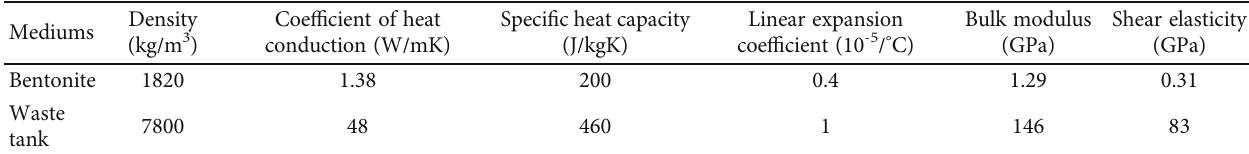
Table 2: Calculation parameters of Waste tank and Bentonite.